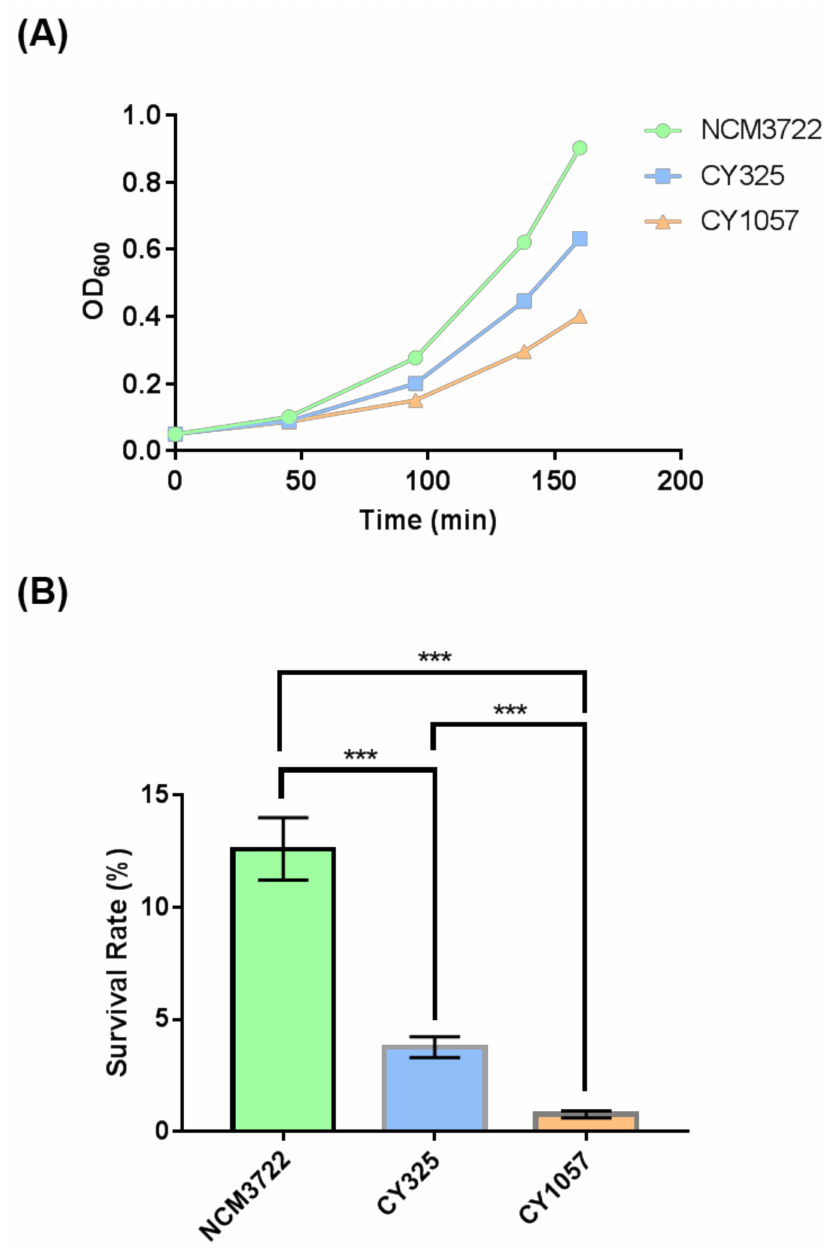
Figure 5. The sensitivity of the gcvB deletion strain to oxidative stress. ( A ) The growth of strains with H 2 O 2 supplied to the medium. The growth curve of each strain was recorded after 3 mM H 2 O 2 was supplied into the growth medium. One representative result of three independent experiments is shown. NCM3722 (WT); CY325 ( ∆ gcvB ); CY1057 ( ∆ oxyR ). ( B ) Survival rate of the three strains after a 10-minute challenge of 20 mM H 2 O 2 . The survival rate is shown as the average ± S.D. of the six replicates in two independent experiments. *** p < 0.001 using Student’s t -test. The endogenous ROS were generated as byproducts of aerobic respiration [50].